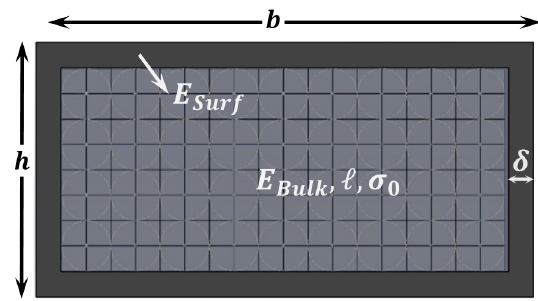
Figure 6. Combined model (RST + CST + SET). Schematic showing the cross section of a layer that shows a thin shell with different Young’s modulus than that of the bulk part, which in turn is described with a length scale parameter and might have some residual stress.